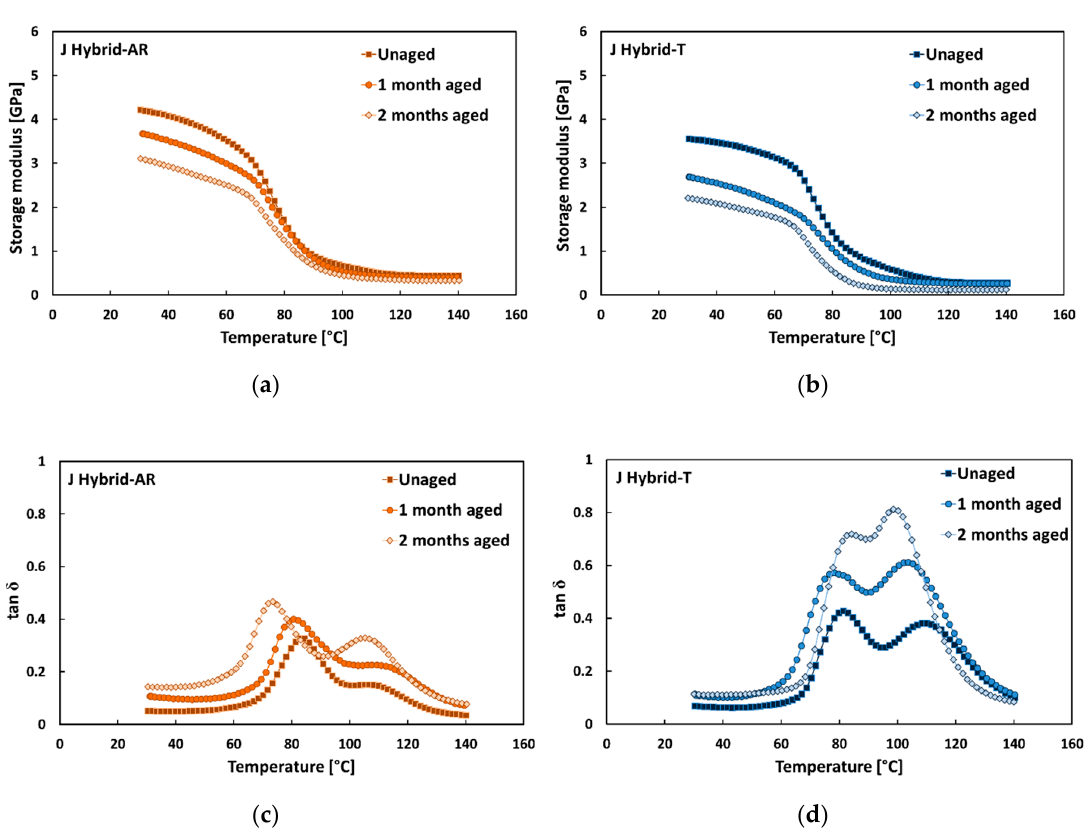
Figure 7. ( a , b ) Typical storage modulus and ( c , d ) tan δ trends of J-Hybrid composites in each Figure 7. ( a ) ‐ ( b ) Typical storage modulus and ( c ) ‐ ( d ) tan δ trends of J ‐ Hybrid composites in each aging aging condition.